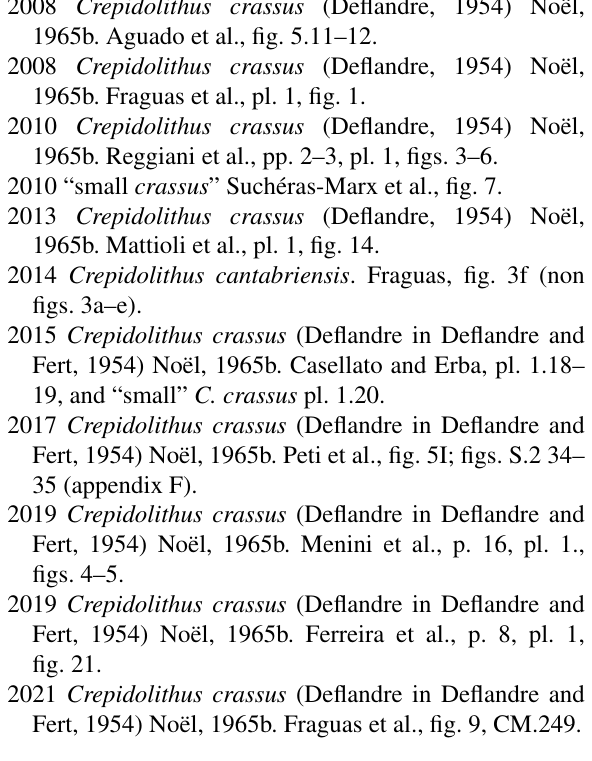
2021 Crepidolithus crassus (Deflandre in Deflandre and Fert, 1954) Noël, 1965b. Fraguas et al., fig. 9, CM.249. Range . Sinemurian–Tithonian (Bown and Cooper, 1998). Occurrence . Given the wide range of C. crassus , this species has been recorded in the entire studied interval. The FO of this species is used by some authors to mark the NJ2–NJ3 zone boundary (Barnard and Hay, 1974; Bown and Cooper, 1998; Fraguas et al., 2015). Remarks . The original diagnosis of Discolithus crassus describes an “elliptical slightly elongated, thick coccolith without an elevated rim, exhibiting an undulated longitudi- nal median line, interrupted in its centre by divergent lat- eral lines and few punctuations (? perforations)” (Deflandre in Deflandre and Fert, 1954, pp. 115–176). Noël (1965b, p. 88) emended this diagnosis, stating that it is “a typi- cal Crepidolithus ”. The punctuation reported by Deflandre and Fert (1954) might be the result of poor preservation of the specimen that they illustrate under light microscope (LM). The later description by Bown (1987b; p. 16) reports a “broad, high, elliptical rim with a vacant central area of- ten reduced to a lenticular slit... The broader the wall the narrower the central area”. Actually, scanning electron mi- croscope (SEM) pictures (Bown, 1987b, pl. 1, figs. 6–9, p. 15) show a variable-sized, vacant central area. In fact, Noël (1965b) and Bown (1987b) observed a certain variabil- ity in the central area of C. crassus , which can be slightly open. Suchéras-Marx et al. (2010) reported two different- sized coccolith morphotypes, named “small crassus ” with a mean size of 6.5 µm and “large crassus ” with a mean size of 8.5 µm. Fraguas and Erba (2010) performed biometric analy- sis on C. crassus and C. crucifer , and they differentiated the J. Micropalaeontology, 41, 75–105,